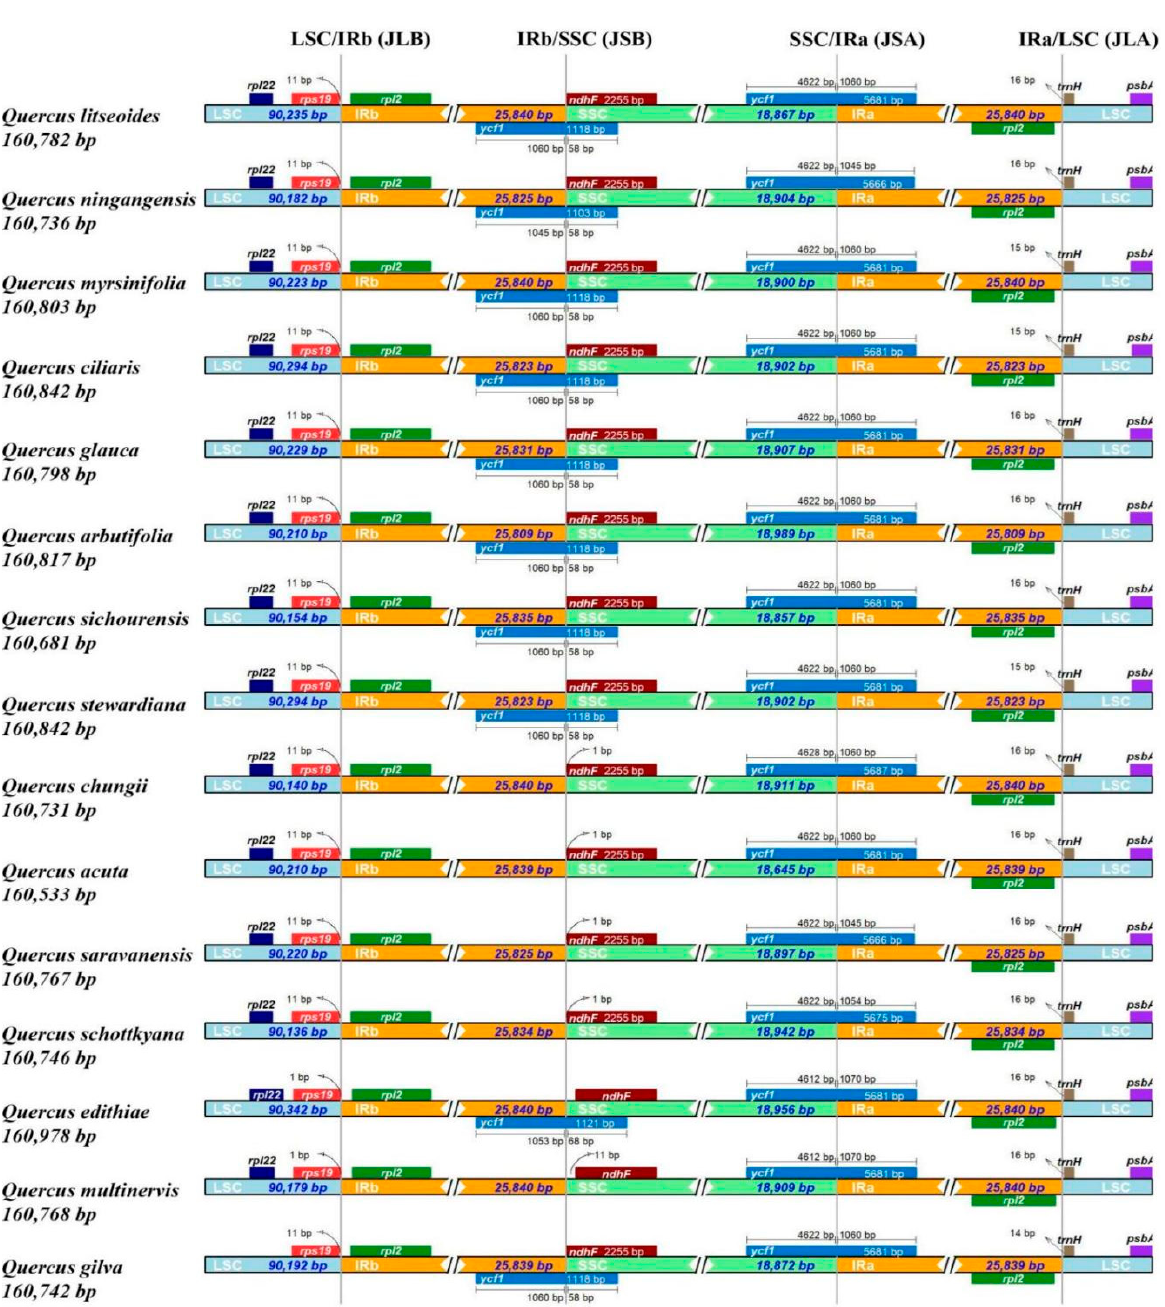
Figure 2. Comparison of the junction regions (JLA, JLB, JSB, JSA) of the chloroplast genomes of Quercus section Cyclobalanopsis .